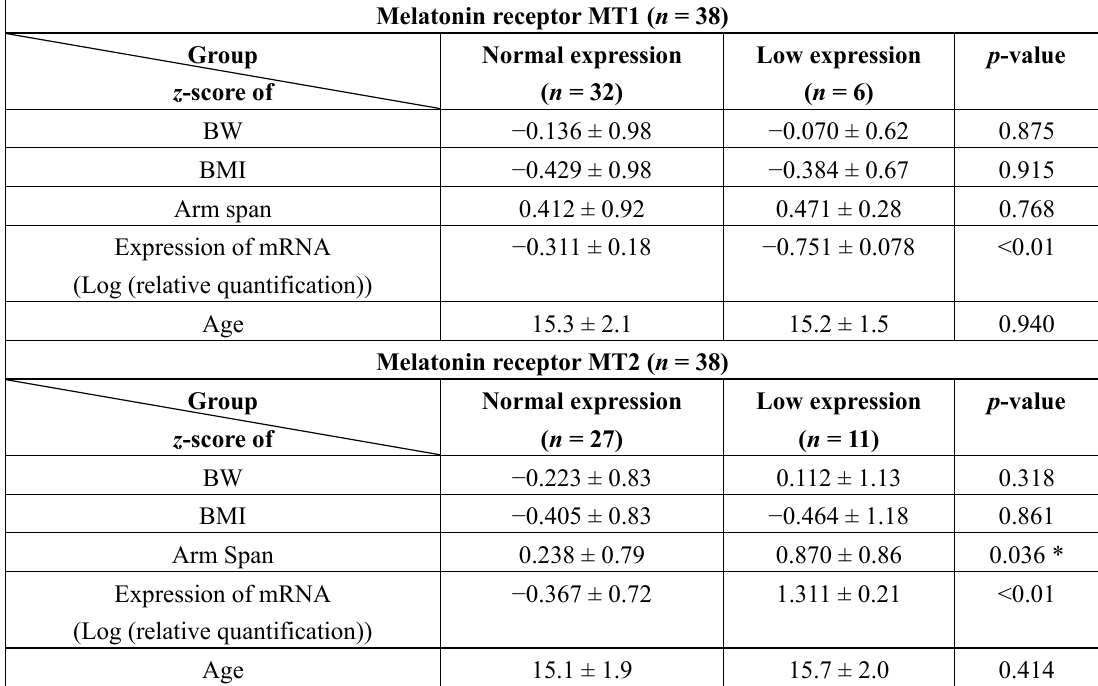
Table 3. Correlation of clinical anthropometric parameters of AIS patients with mRNA expression of melatonin receptor MT1 and MT2. The AIS patients were divided into groups according to their mRNA expression level of melatonin receptor MT1 or MT2 using the minimum value of normal controls as the cut-off point. Their anthropometric parameters [body weight (BW), body mass index (BMI) and arm span] were compared by Student’s t -test, * p < 0.05. All data were expressed as the mean ±